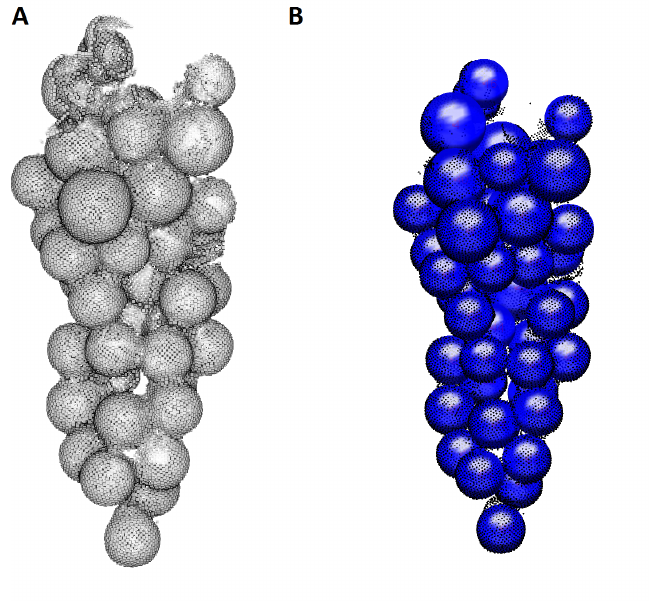
Figure 14. ( A ) The grape bunch scanned with the Perceptron line scanner; ( B ) The spheres found by findBerries. Partially-reconstructed berries suffice for correct sphere approximation.